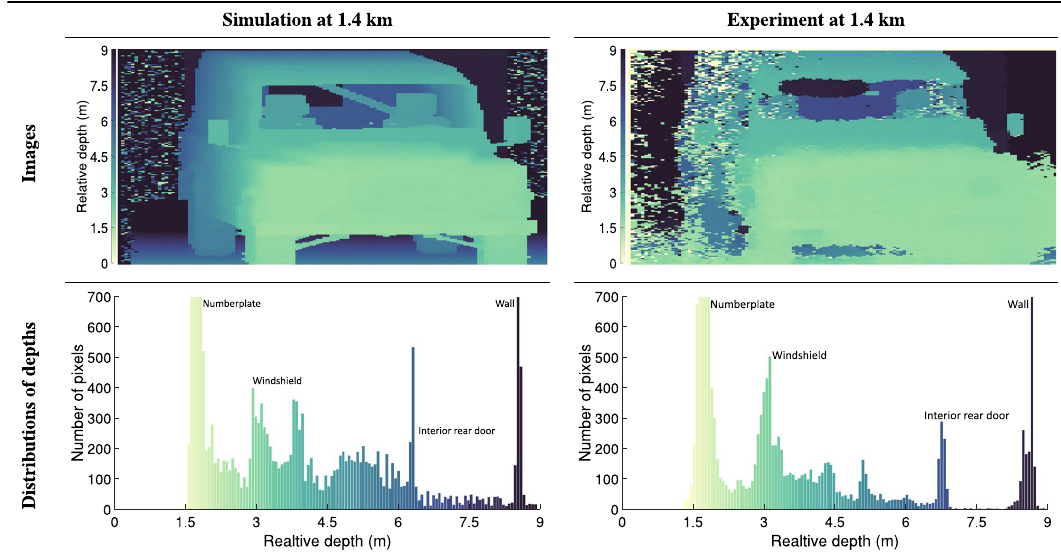
Figure 8. Quantitative and qualitative comparison between the simulated and measured depth images for the Landrover. Top row; the depth images derived from the simulated (left) and experimental (right) histograms respectively. Bottom row; the number of pixels at a given depth as a histogram for the simulated (left) and measured (right) results. The annotations represent the physical component in the image corresponding to the peak in the